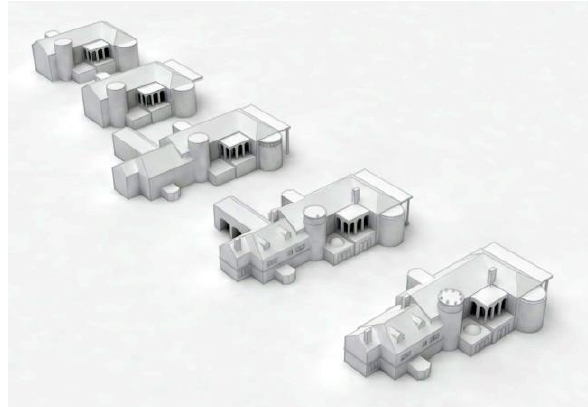
Figure 9. Iterative versions of the mansion reflecting changes in available